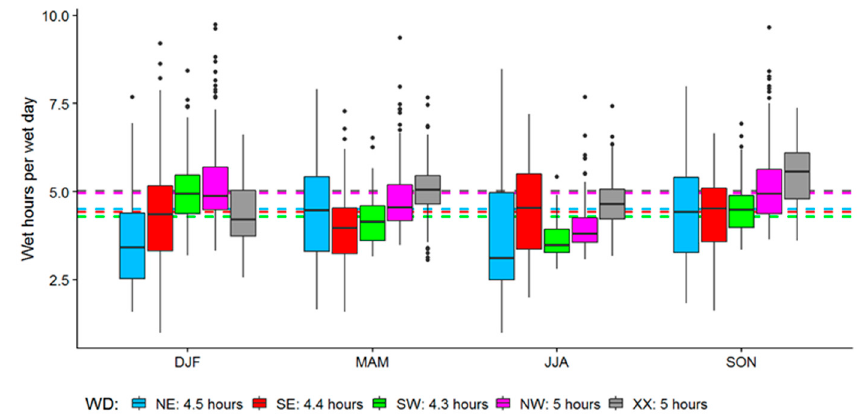
Figure 6. Average number of hours per wet day per wind direction (WD) in each season. The boxplots represent the distribution of the number of wet hours across all stations colored by the WD class. The horizontal colored lines and the associated numbers in the legend represent the mean number of wet hours per wet day across all years and stations for each WD class, regardless of the season. For the WD classes, see Section 2.1. The representation of the boxplot is same as explained in Figure 5.